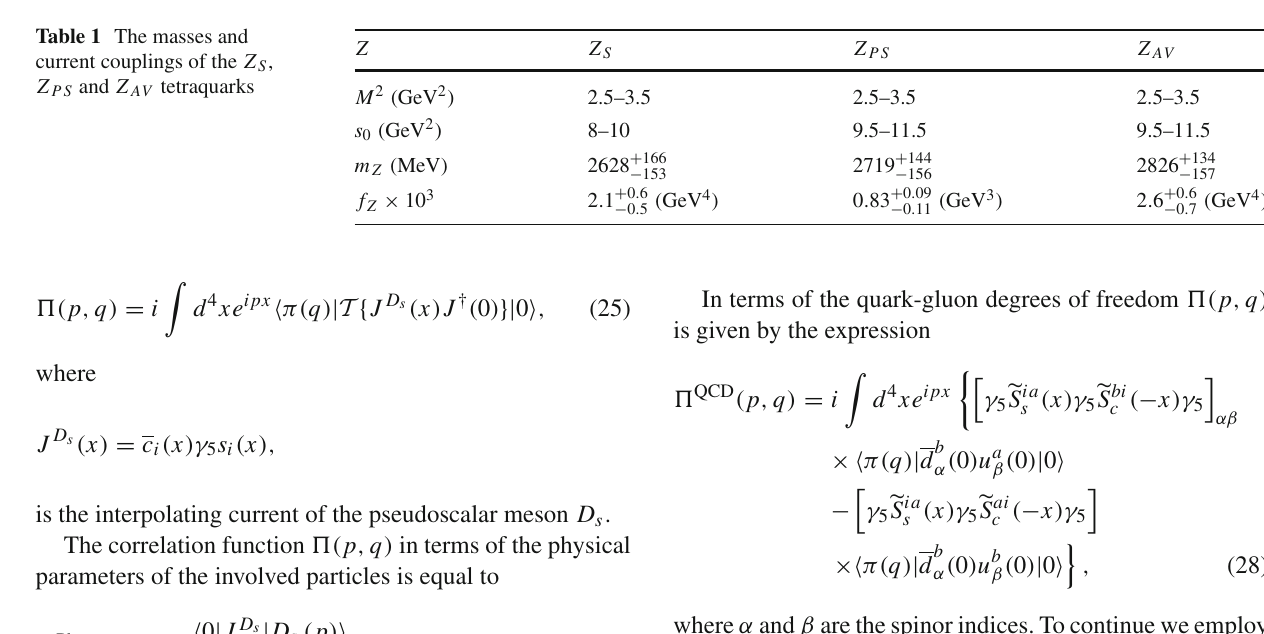
of the Z AV state vs Borel parameter M 2 at chosen values of s 0 (left panel), and vs s 0 at fixed values of M 2 AV